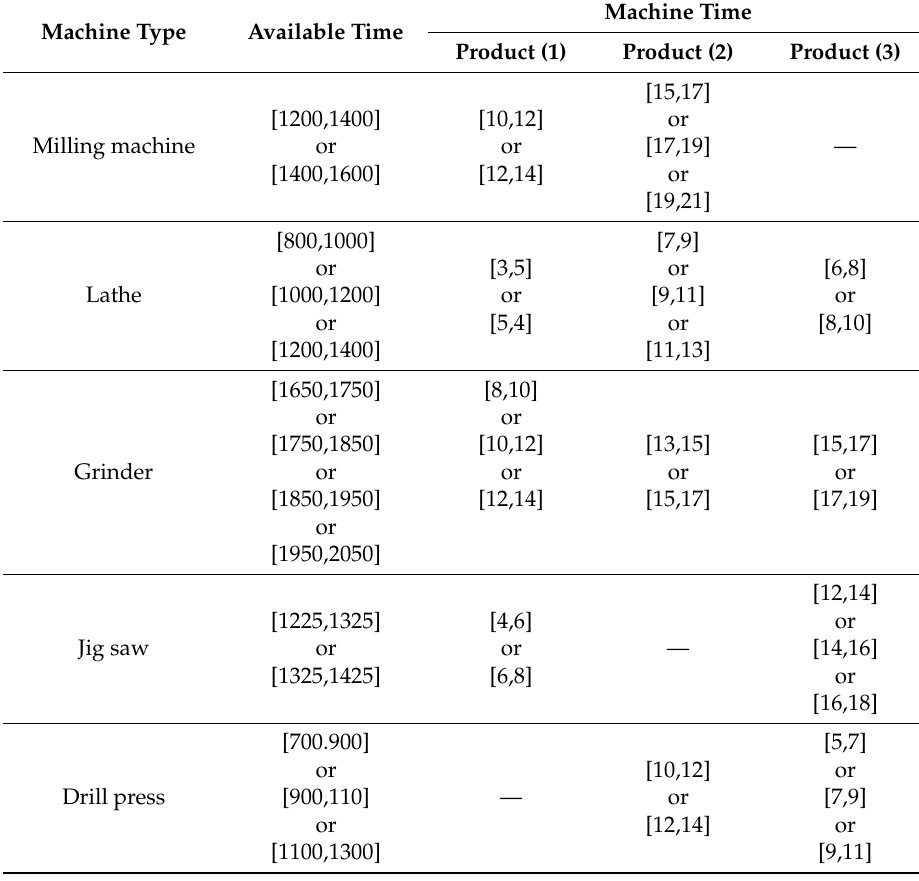
Table 2. Portfolio of available capacities with multi-choice